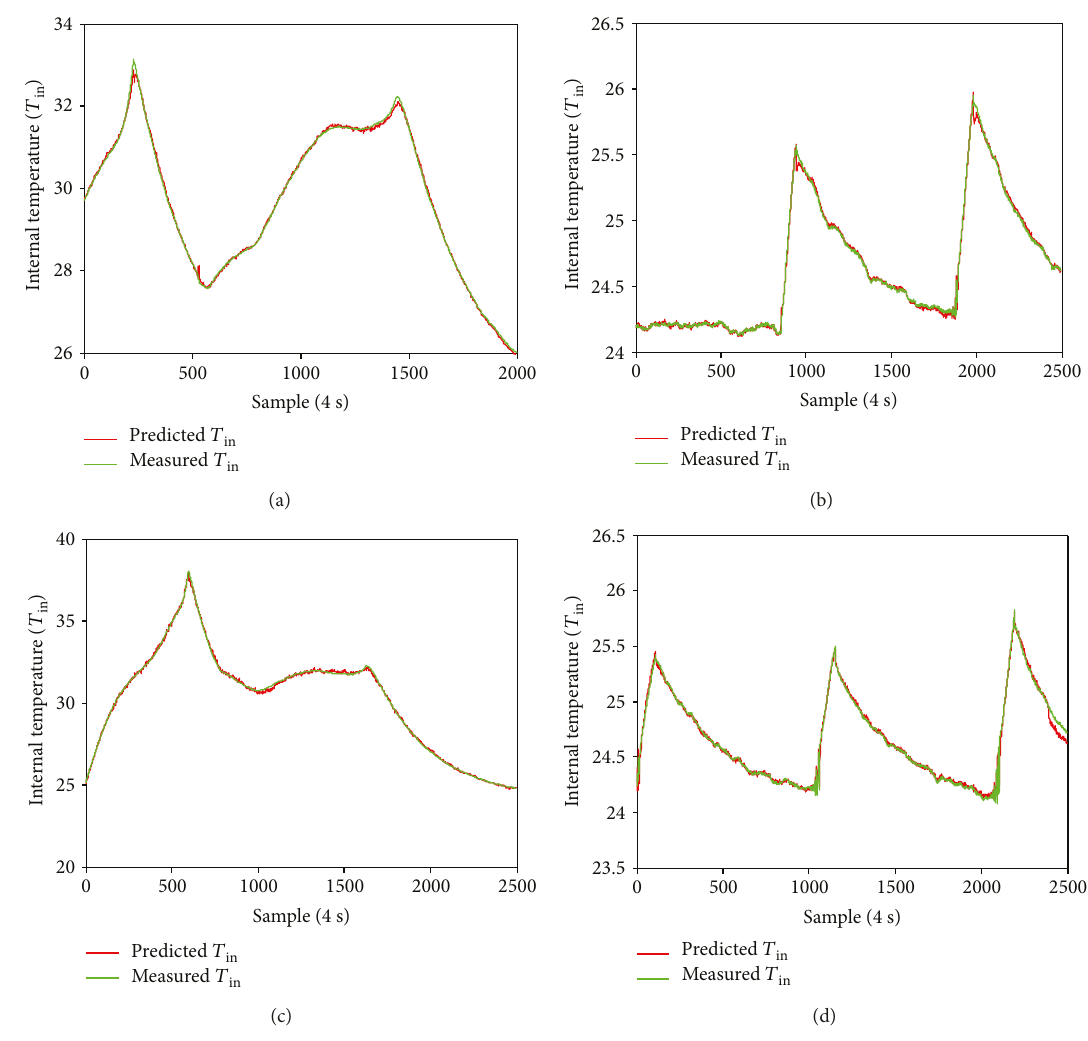
Figure 8: Validation results for T